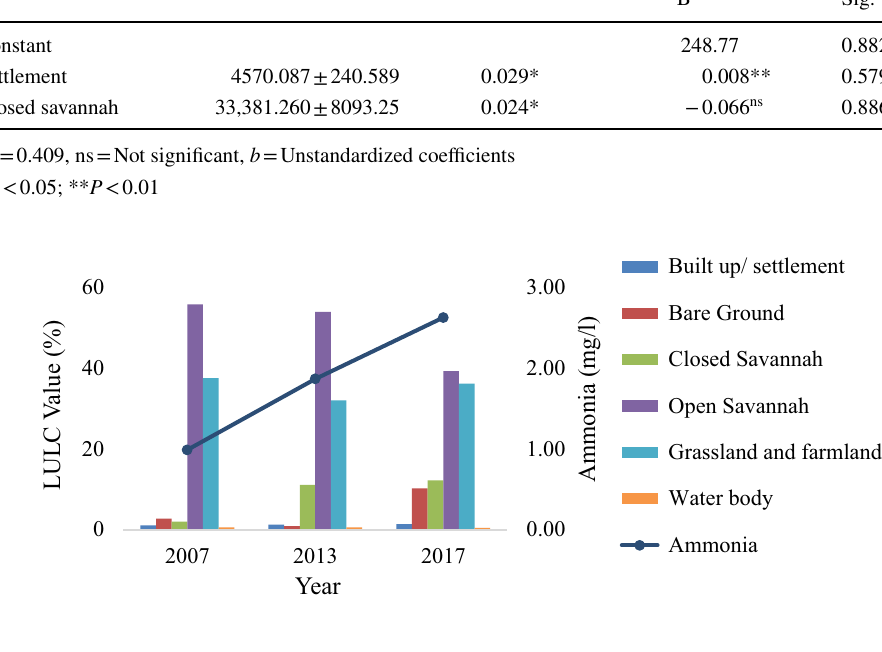
Table 3 Relationship between changing turbidity levels and land use and land cover changes (LULCC)